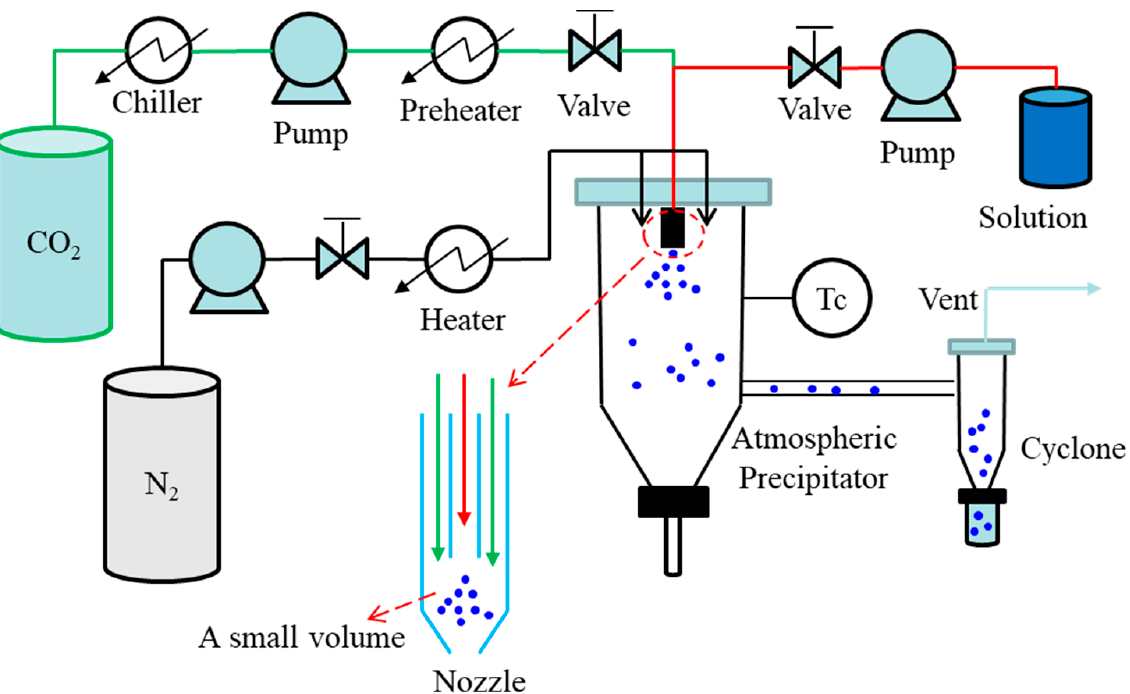
Figure 4. Schematic diagram of continuous SAS process: ASAIS process.